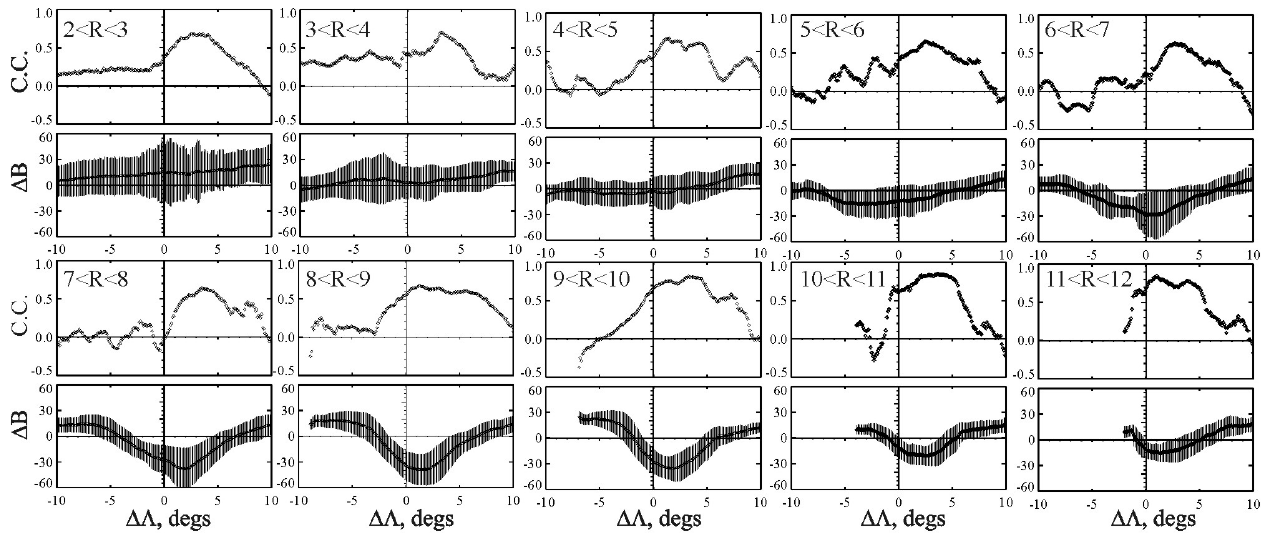
Fig. 5. Latitudinal profiles across the model cusp of the correlation coefficient between B y field component observed in and around the cusp and B ( IMF ) y (upper panels in each of the 10 plots), and of the scalar anomaly 1B =| B obs |−| B IGRF | (lower panels). Both quantities are plotted for 10 intervals of the radial distance R , covering the range 2 ≤ R ≤ 12 R E . Rms deviation of 1B is shown by vertical shading.